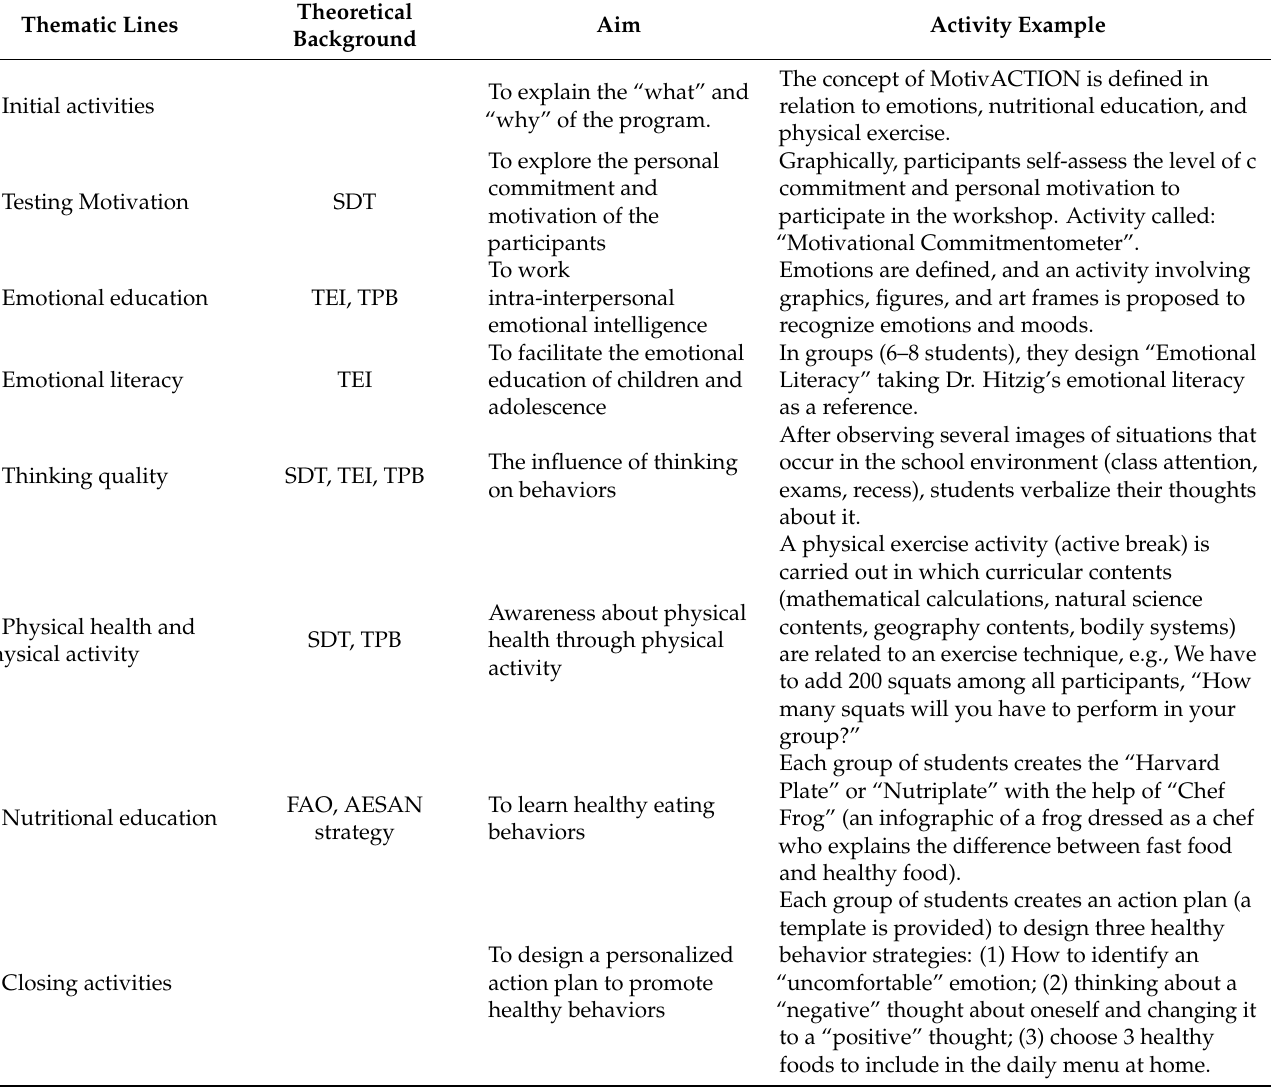
Table 2. Workshops carried out in the education